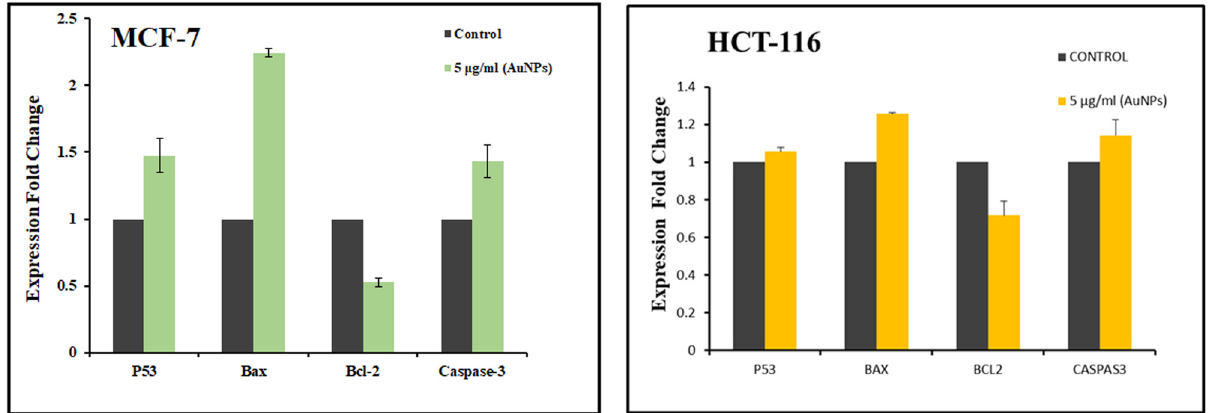
Figure 7: E ff ect of AuNPs on pro/anti - apoptotic marker mRNA expression levels. Changes in mRNA expression levels caused by nanos - tructures are expressed as a fold change in relative quantity compared to control cells. Other genes ’ cycle threshold values were computed using GAPDH as a